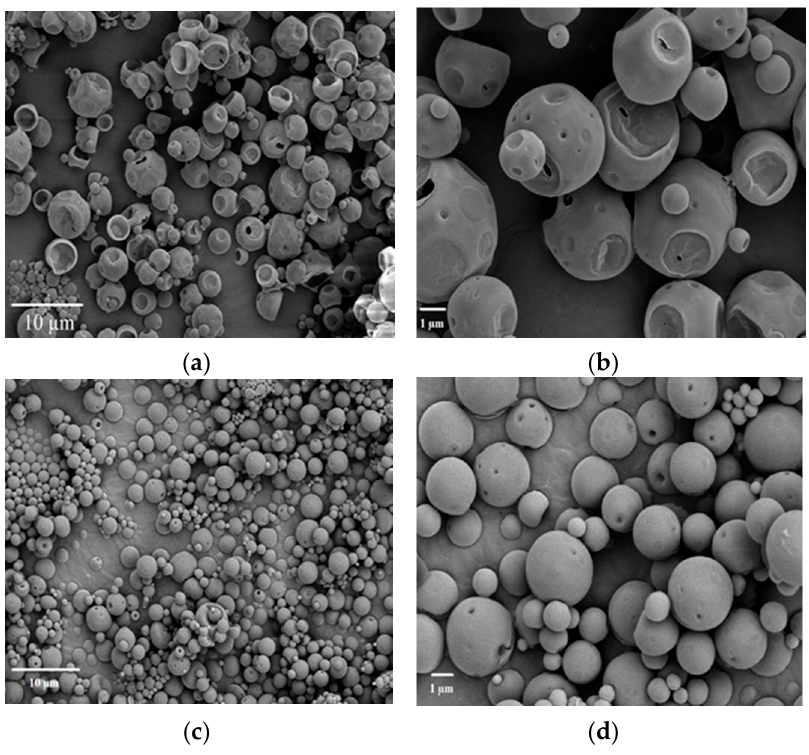
Figure 4. Field-emission scanning electron microscope (FE-SEM) images of lysozyme loaded double-walled microspheres prepared with 2.5% trehalose ( w / v ) in internal aqueous phase at different resolution: ( a ) 2000 × mag; ( b ) 6000 × mag and double-walled microspheres prepared with 1% PVA ( w / v ) in internal aqueous phase; and, 2.5% trehalose ( w / v ) in external aqueous phase at different resolution: ( c ) 2000 × mag; ( d ) 6000 ×